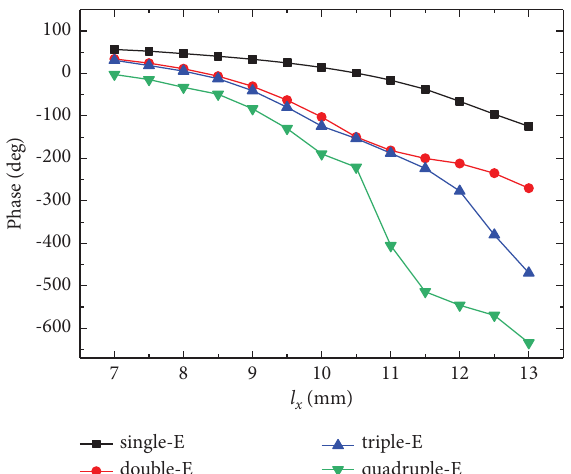
Figure 7: Refection phases versus the size of the unit cell of 0 ° for the four types of the E -shape